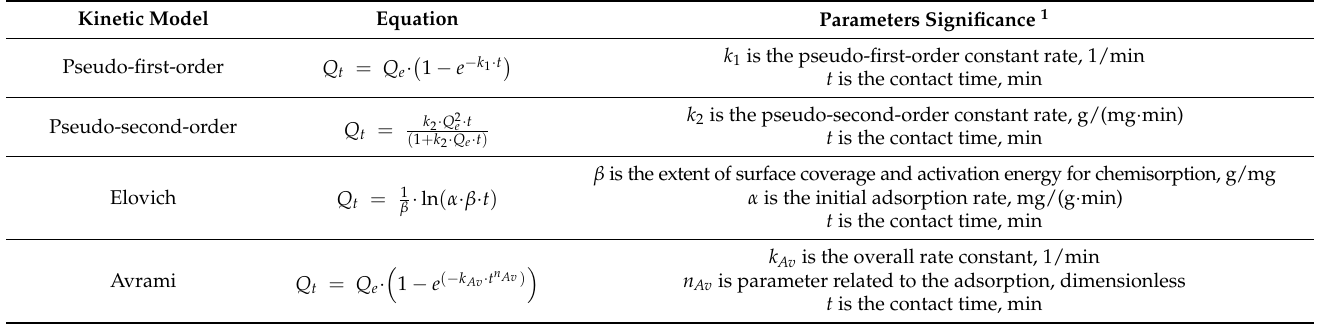
Table 1. Nonlinear equations of kinetic models.